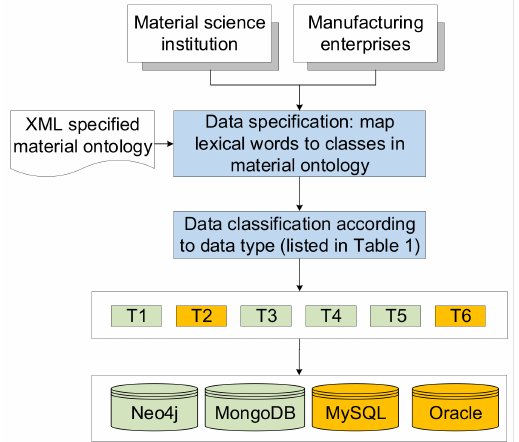
Figure 2. Material data collection and storage